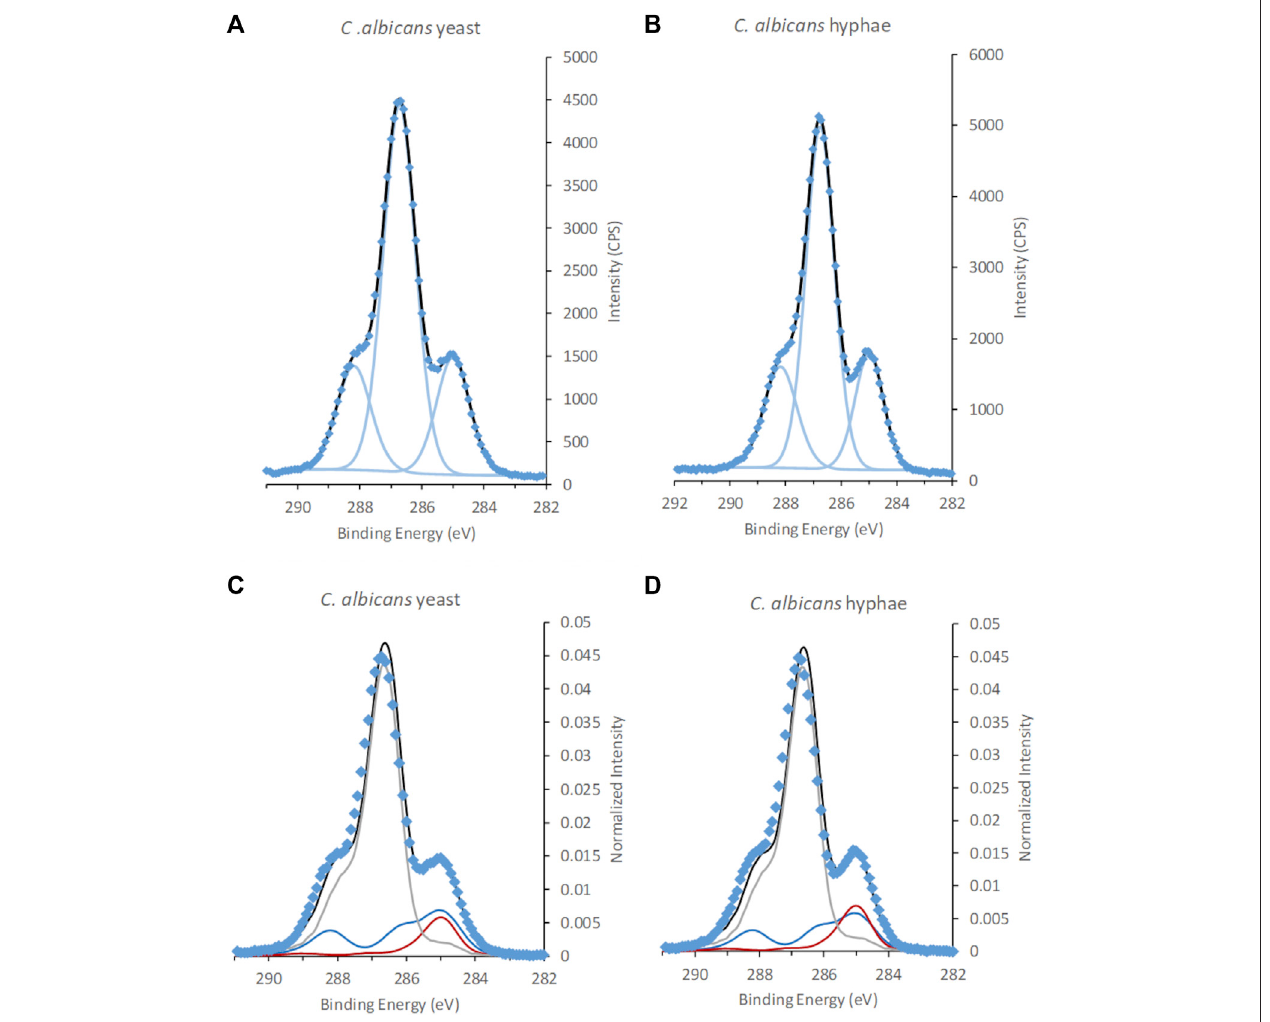
FIGURE 4 | XPS C 1s spectra of C. albicans in the form of (A,C) , yeast and hyphae (B,D) . Spectra in (A) and (B) are fi tted using traditional fi tting of Gaussian- Lorentzian (GL30) peak shapes, (C,D) fi tted using spectral components. Data is represented by blue diamonds, the fi t by a solid black line, GL30 peak shapes are represented by light blue lines in fi gures (A,B) , and in (C,D) the blue line represents protein-like substance, grey line polysaccharides and red line lipid-like